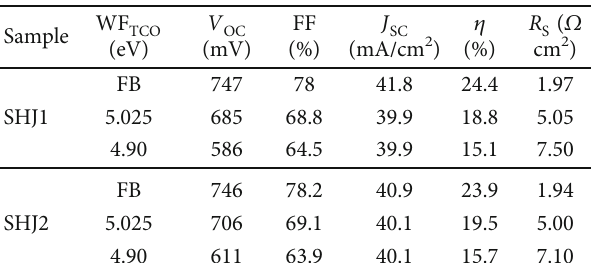
Table 2: Values of V , FF , J , and cell e ffi ciency extracted from OC SC the I-V curves of the two simulated structures SHJ1 and SH2 for di ff erent values of WF . TCO